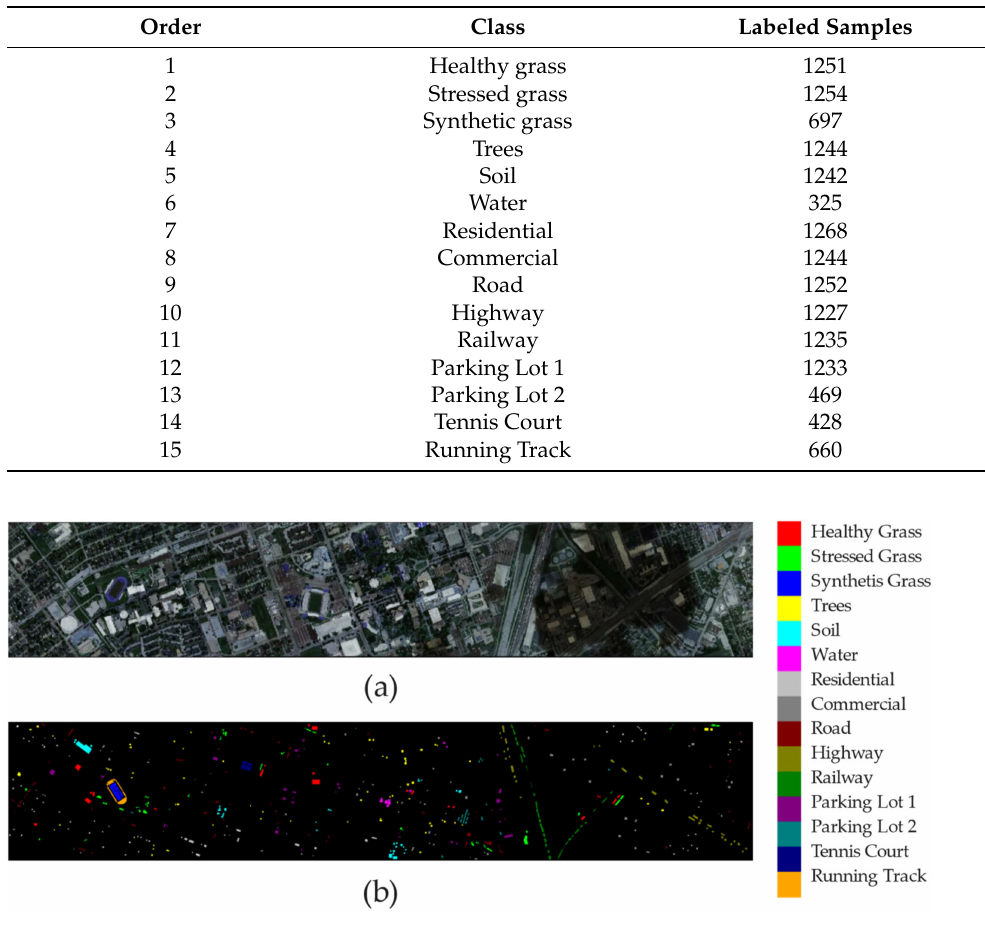
Figure 11. Houston dataset: ( a ) false-color map, ( b ) ground truth